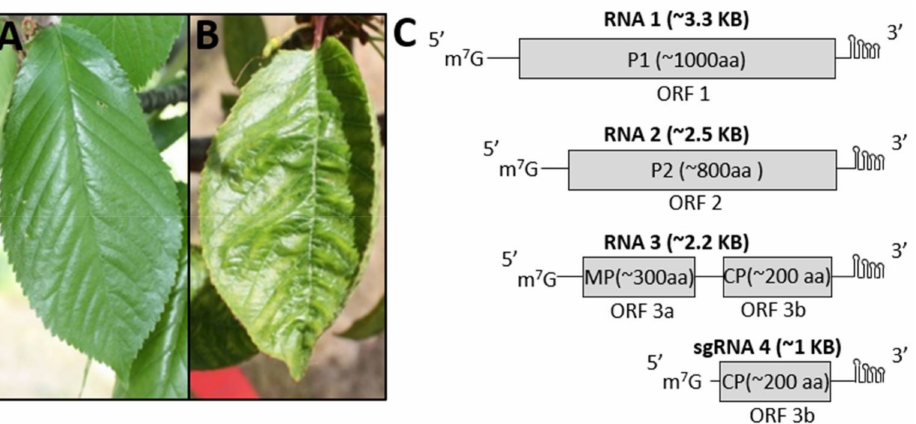
Figure 1. Source and genome structure of PDV. ( A ) A healthy, asymptomatic leaf from a cherry tree showing an even distribution of green colouring, absence of damage or other deformations. ( B ) A symptomatic leaf from a cherry tree showing symptoms commonly associated with viral infection including chlorosis (yellowing) and uneven distribution of green colouring, vein suturing and leaf curl. ( C ) A diagram showing the genome structure of PDV. Every genomic ssRNA( + ) fragment is shown with approximate lengths in parentheses. Encoded proteins are shown as gray boxes. All RNA fragments have putative m7G cap structures at the 5 (cid:48) UTR, and each 3 (cid:48) UTR is predicted to adopt complex secondary structures. RNA 1 encodes the P1 protein which has Met and Hel domains which are essential for viral replication. RNA 2 encodes the RdRp (P2). RNA 3 directly encodes the MP. The fourth RNA fragment, sgRNA 4 is transcribed from RNA 3 downstream of ORF3a and encodes the viral CP. m7G: 5 (cid:48) -7-methyl-G cap;